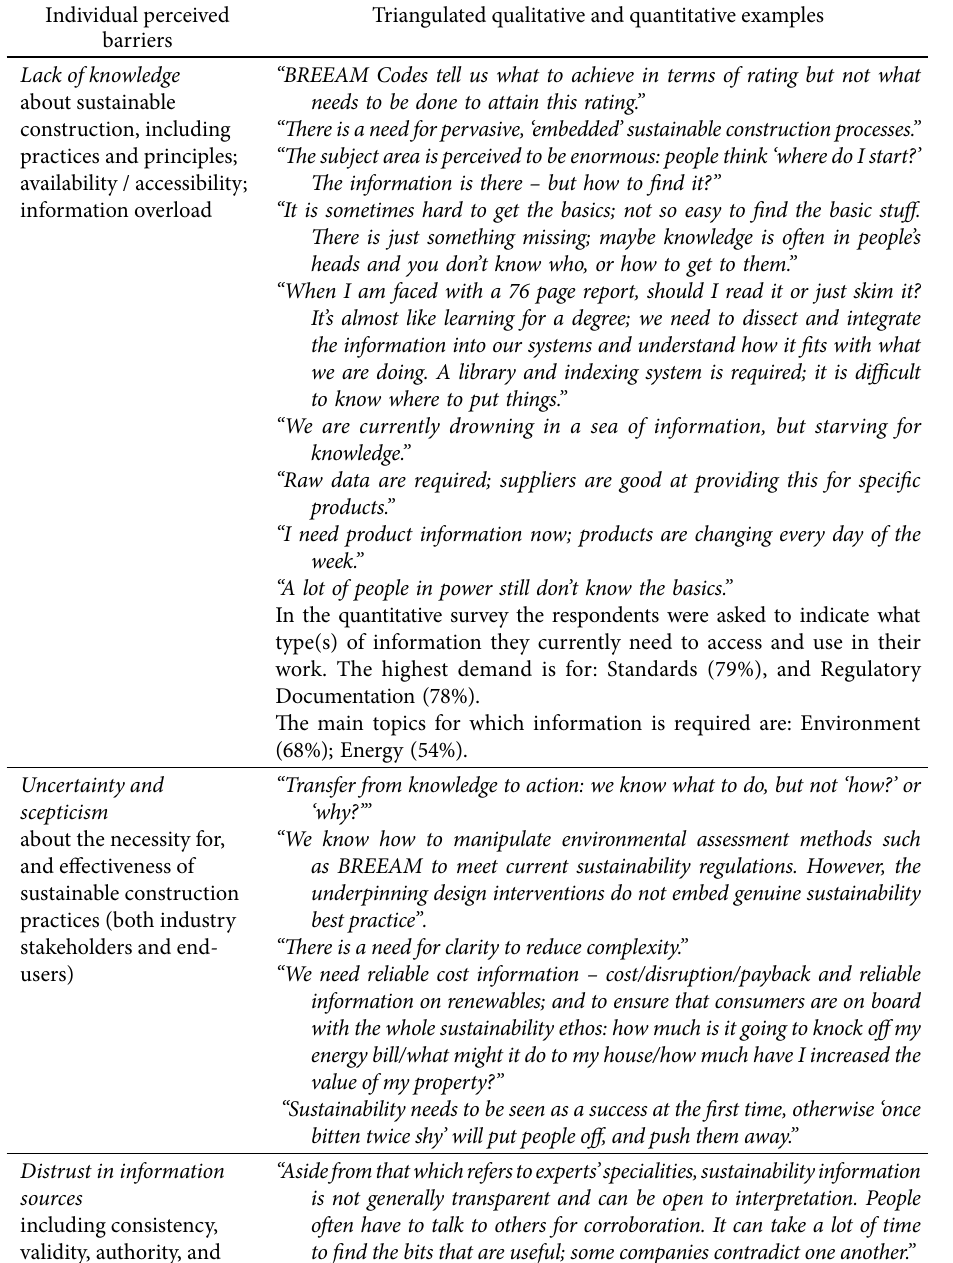
Table 2. Individual perceived barriers to engagement with sustainable construction Individual perceived Triangulated qualitative and quantitative barriers